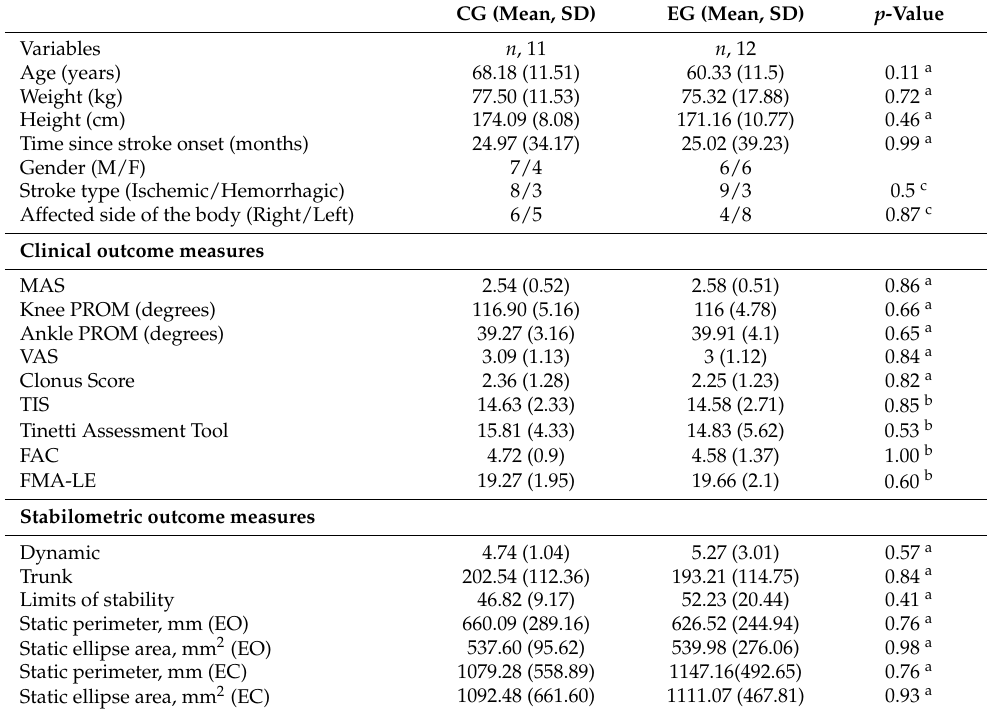
Table 2. Characteristics of participants at baseline, clinical, and stabilometric outcome measures.